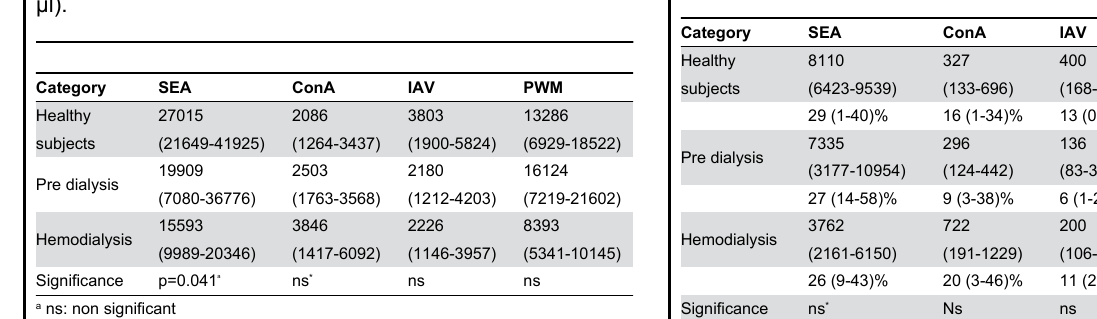
Table 3. Absolute number of activated lymphoblasts (cells/ µl).